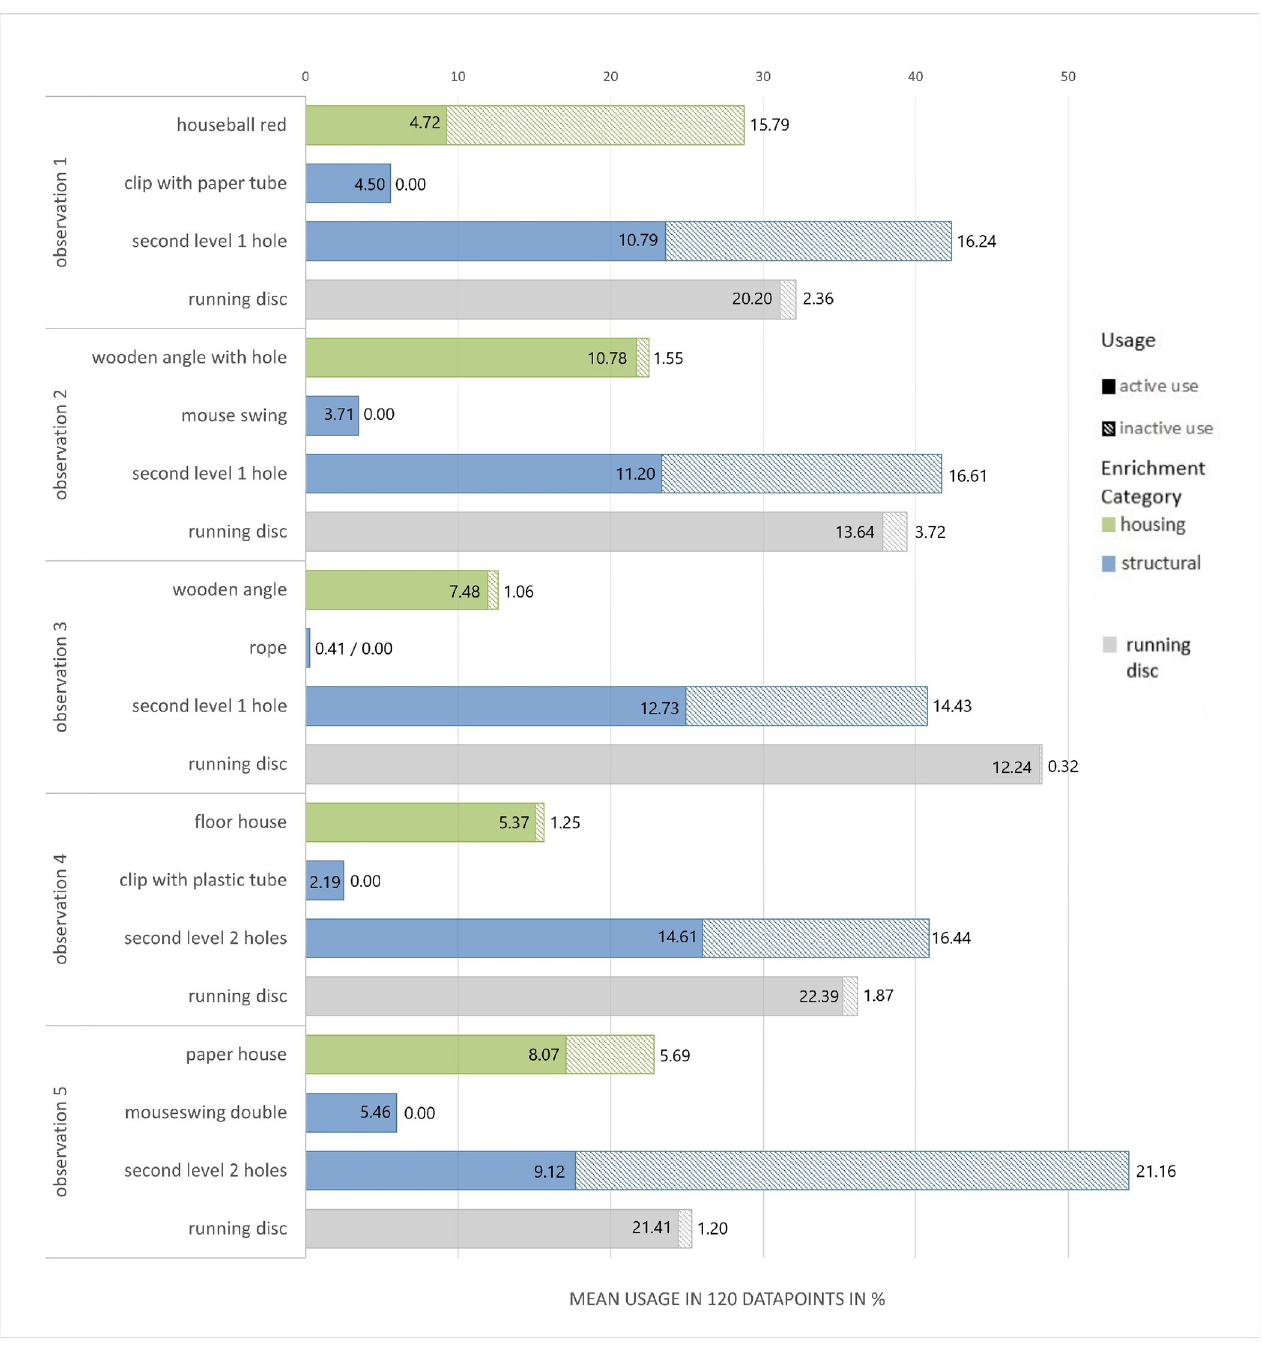
Fig 7. Video analysis of the active and inactive enrichment use in 5 observations of mice in enriched housing conditions (12 mice in 3 groups of 4 per cage) given as mean % of 120 datapoints. The running disc was provided in every enrichment item combination. Solid parts of the bars depict the active use of the respective elements and dashed parts of the bars depict the inactive use. Standard deviations for each stagged bar are given as numbers (inside bar for active use, outside for inactive use). Mice could use more than one item within each bout of 15s scan sampling therefore the added values of the bars might exceed